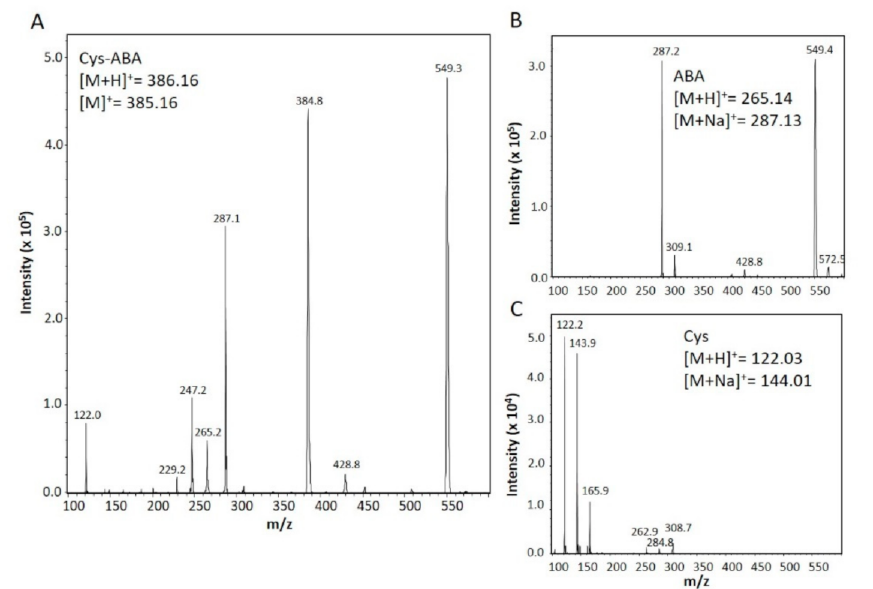
Figure 2. Mass spectrometric analysis of the interaction product of abscisic acid (ABA) with Cys. MS spectra of the ABA–Cys mixture ( A ) revealed adduct formation at 384.8 m / z . This peak was not observed with ABA ( B ) or Cys ( C ). ESI-MS spectra were recorded with the Bruker Daltonics Esquire 3000 in positive ionization mode. For details, see Section